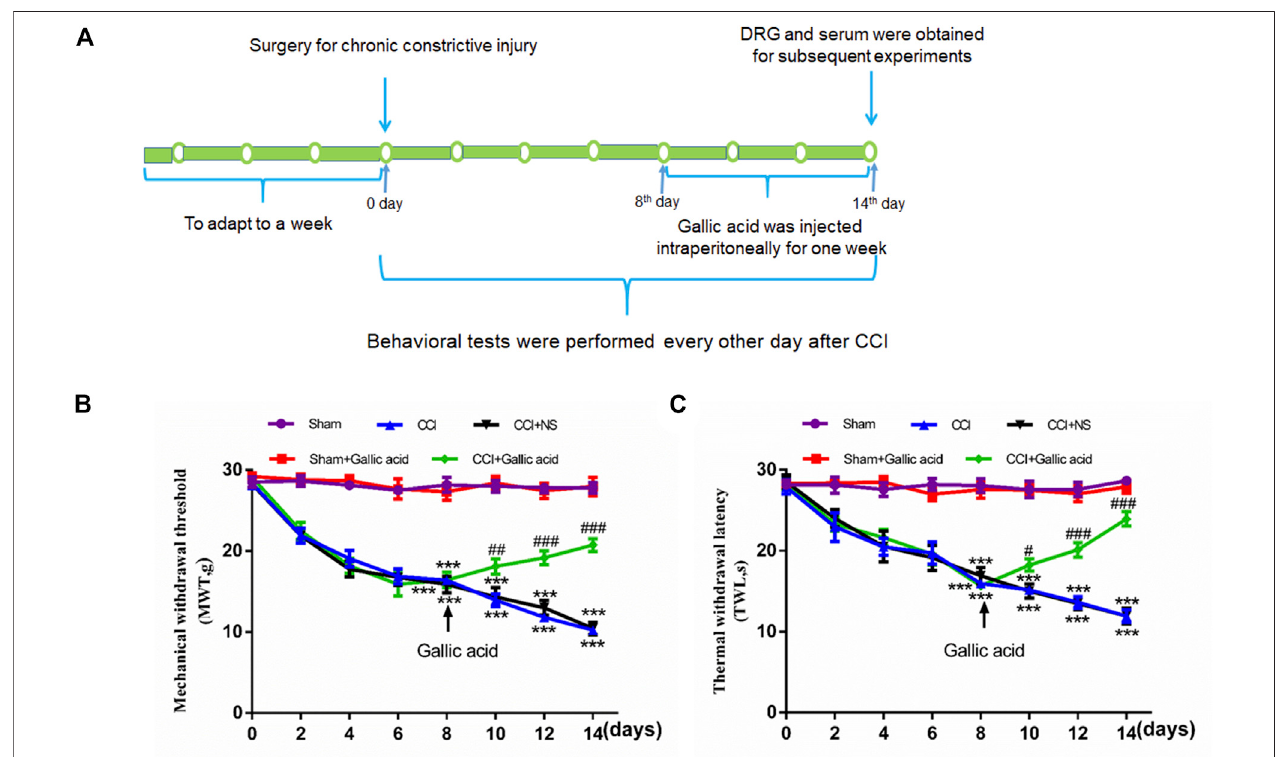
FIGURE 1 | Timeline of model establishment and pain behaviors results. (A). Timeline of CCI modeling and drug treatment. (B). Changes in the mechanical withdrawal threshold (MWT) in rats subjected to gallic acid (time: F (7, 80) (cid:2) 69.95, p < 0.001; Group: F (4, 80) (cid:2) 353.8, p < 0.001; interaction: F (28, 80) (cid:2) 12.78, p < 0.001). (C). Changes in the thermal withdrawal latency (TWL) in rats subjected to gallic acid (time: F (7, 80) (cid:2) 9.974, p < 0.001; Group: F (4, 80) (cid:2) 198.9, p < 0.001; interaction: F (28, 80) (cid:2) 7.213, p < 0.001). Each group consisted of eight rats. Two-way ANOVA and Tukey ’ s honestly signi fi cant difference test were used to analyze the MWT and TWL. Data are presented as mean ± SEM. *** p < 0.001 versus the Sham group, # p < 0.05, ## p < 0.01 and ### p < 0.001 versus the CCI